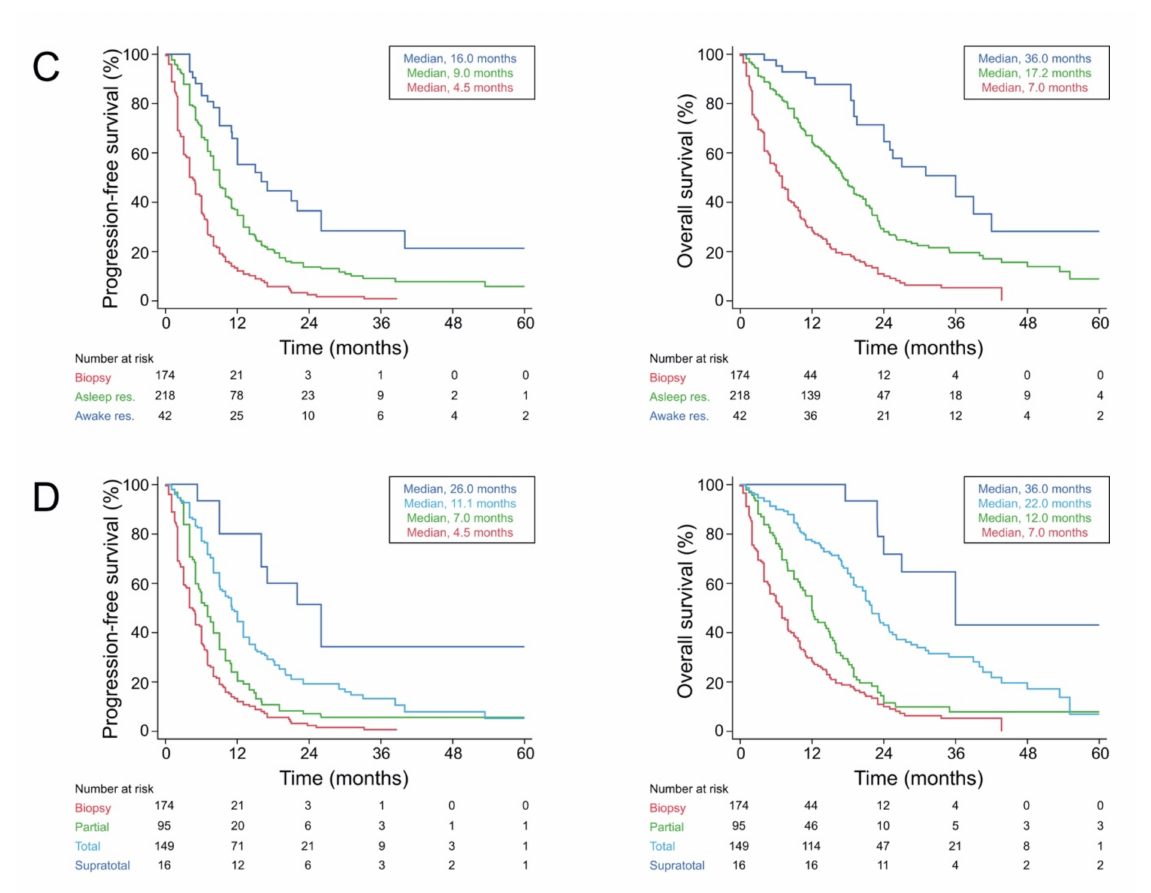
Figure 3. Kaplan–Meier estimates of progression-free and overall survival. ( A ) Kaplan–Meier estimates of progression-free survival (left) and overall survival (right) in the whole study population (434 patients). ( B ) Kaplan–Meier estimates of progression-free survival (left) and overall survival (right) according to the first-line oncological treatment received following surgery: standard radiochemotherapy (Stupp, blue line), other oncological treatment (Other, green line), and no treatment (No treatment, red line). ( C ) Kaplan–Meier estimates of progression-free survival (left) and overall survival (right) according to the type of surgery performed: biopsy (Biopsy, red line), surgical resection under asleep conditions (Asleep, green line), and surgical resection under awake conditions (awake, blue line). ( D ) Kaplan–Meier estimates of progression-free survival (left) and overall survival (right) according to the extent of surgical resection: biopsy (Biopsy, red line), partial surgical resection (Partial, green line), total surgical resection (total, light blue line), and supratotal surgical resection (supratotal, blue